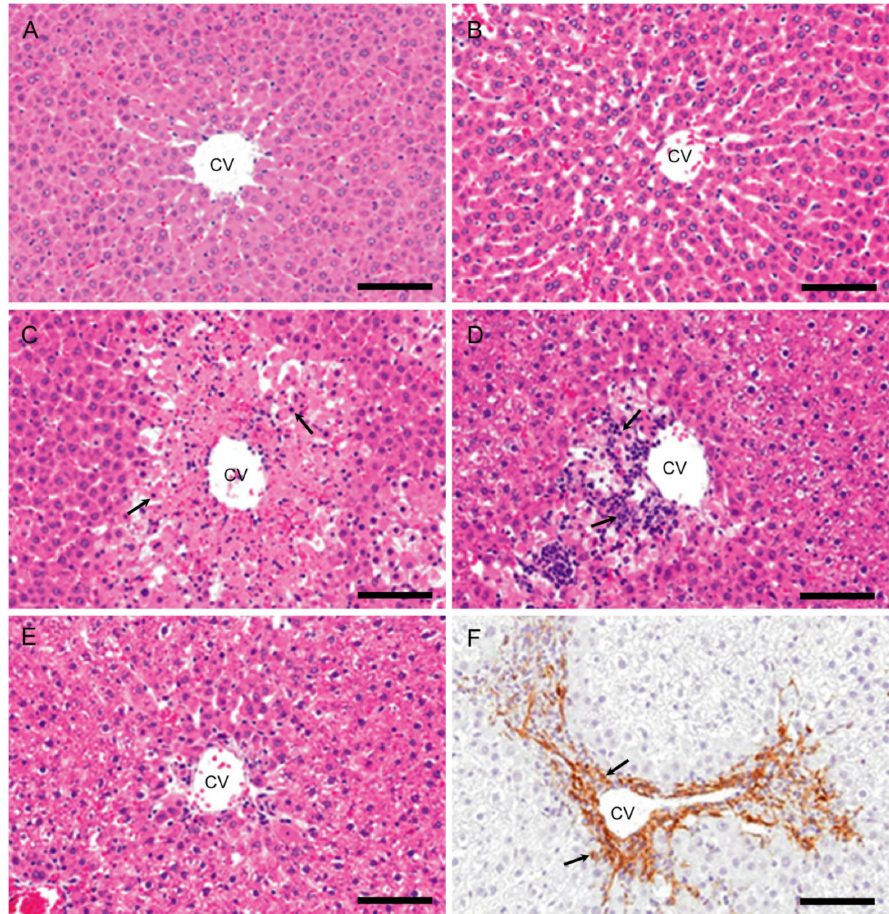
Figure 2. Histopathology of APAP-induced rat hepatotoxicity. In the control ( A ) and at hour 10 ( B ), no significant changes are observed. On day 1, coagulation necrosis of hepatocytes (arrows) accompanied by a small number of inflammatory cells is seen in the a ff ected centrilobular areas ( C ). On day 2, coagulation necrosis with increased infiltration of inflammatory cells (arrows) is seen in the centrilobular areas ( D ). On day 3, the inflammatory cells are almost decreased, and fibrosis develops ( E ). Myofibroblasts immunopositive for α -SMA (arrows) are seen in the fibrotic areas on days 3 ( F ). Hematoxylin and Eosin ( A – E ) and immunohistochemical stain, counterstained with hematoxylin ( F ). CV, central vein. Bar = 50 µ